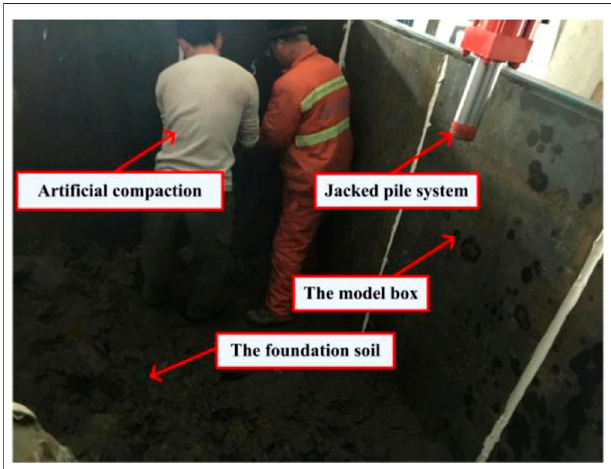
FIGURE 3 | Grounding of foundation soil.